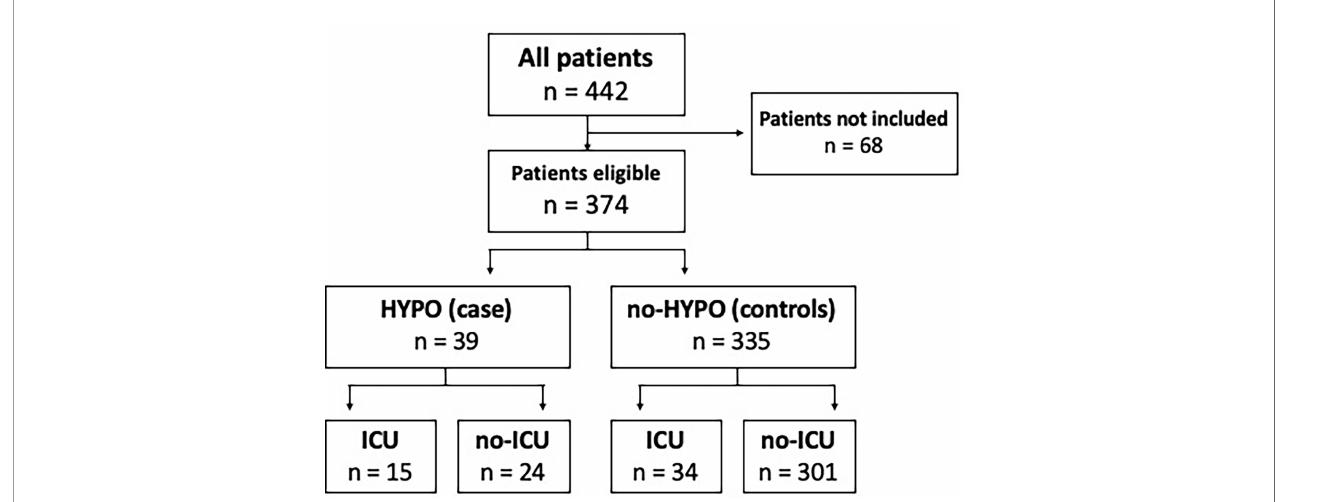
FIGURE 1 | Distribution of hypogammaglobulinemia and ICU admission in our COVID-19 cohort. A total of 68 patients were not included due to lack of serum protein electrophoresis, informed consent and/or not eligible for s-ICU/ICU. HYPO, hypogammaglobulinemia; ICU, intensive care